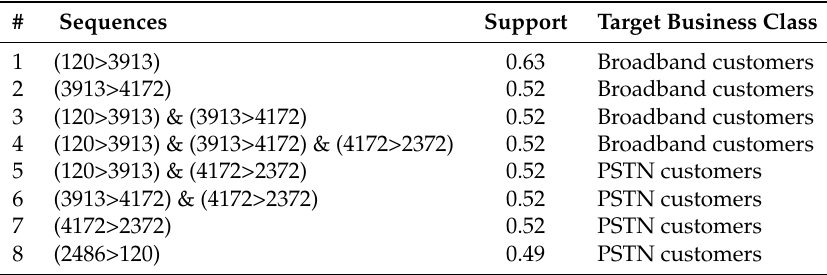
Table 2. Sample results of sequential rules